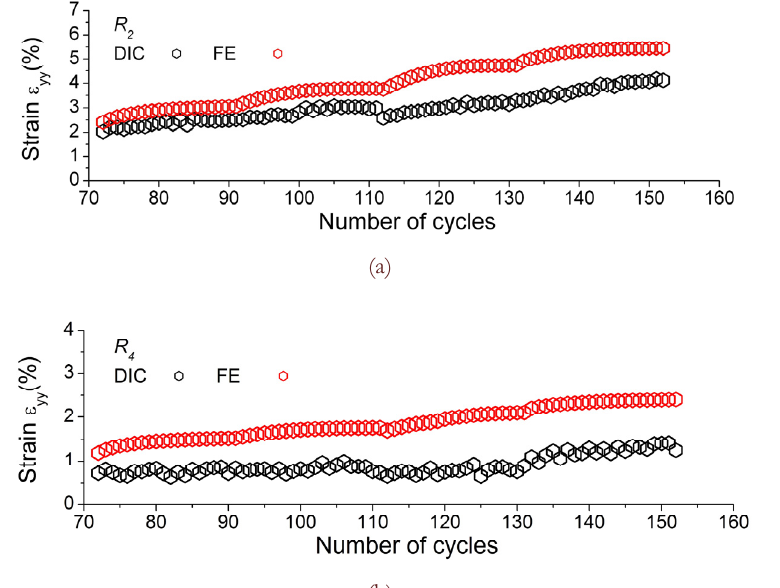
Figure 4: Strain responses at (a) R 2 and (b) R 4 with the number of cycles for the four test series (Fig. 1), comparison of the results from the DIC and the FE